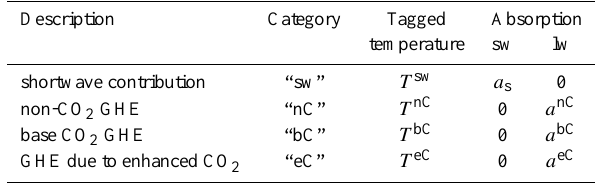
Table 1. Overview on tagging